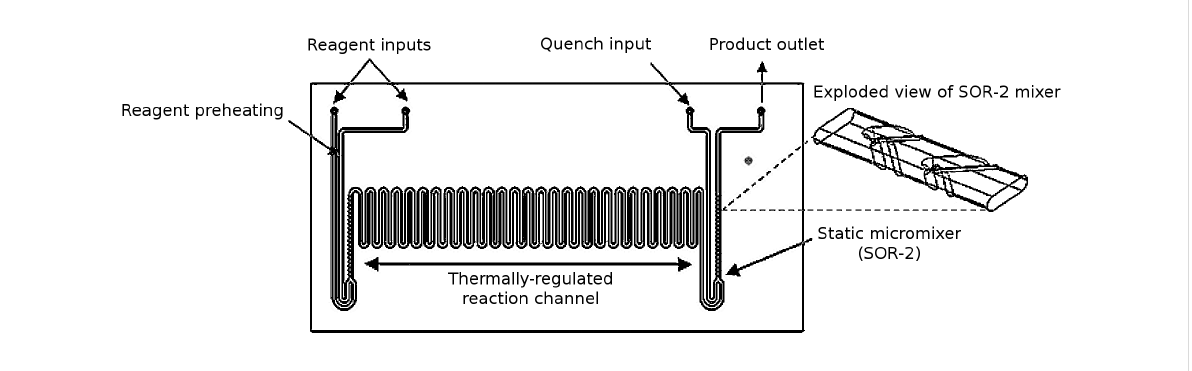
Figure 3: Schematic illustrating the 10 µL reactor manifold used for the S N Ar reactions described herein (3223; Chemtrix BV, NL), with the important features highlighted.